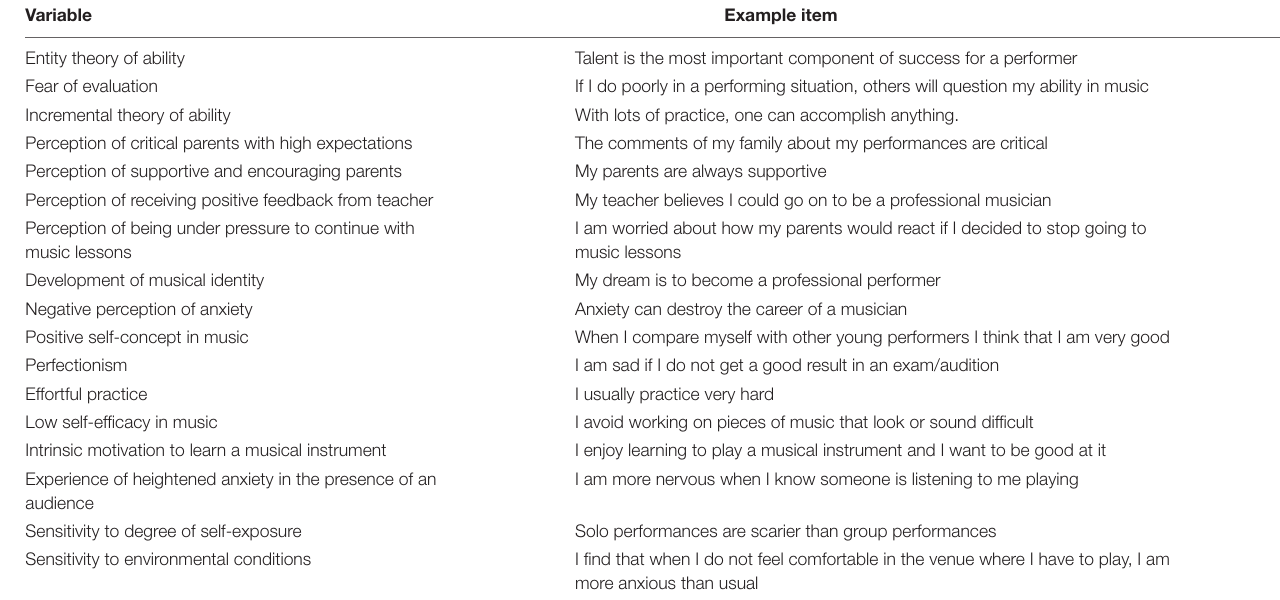
TABLE 1 | Variables included in section B of the questionnaire.